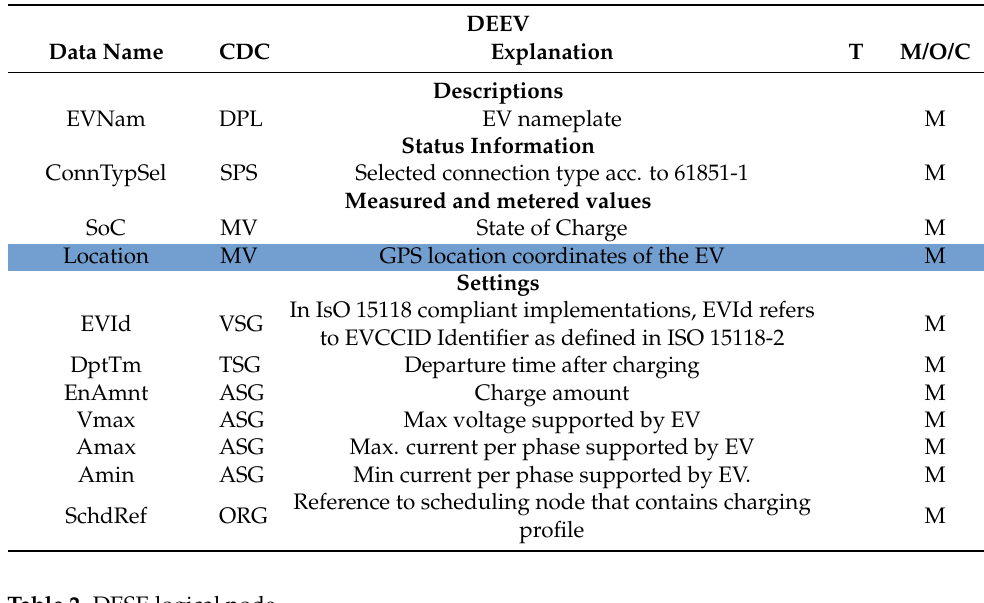
Table 1. DEEV logical node.